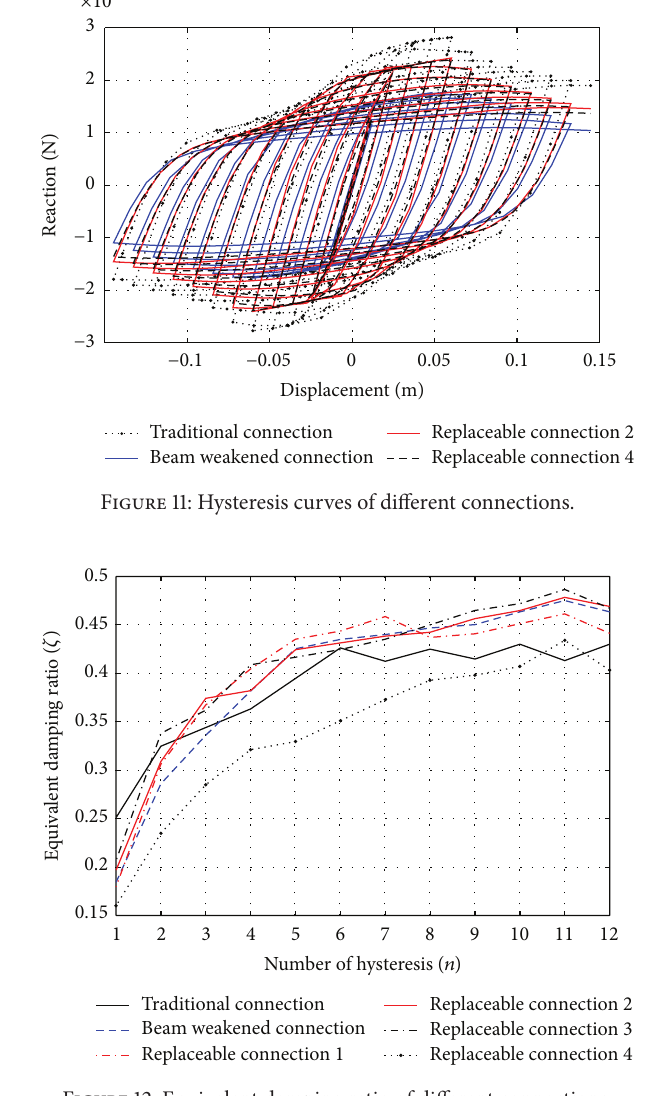
Figure 12: Equivalent damping ratio of different